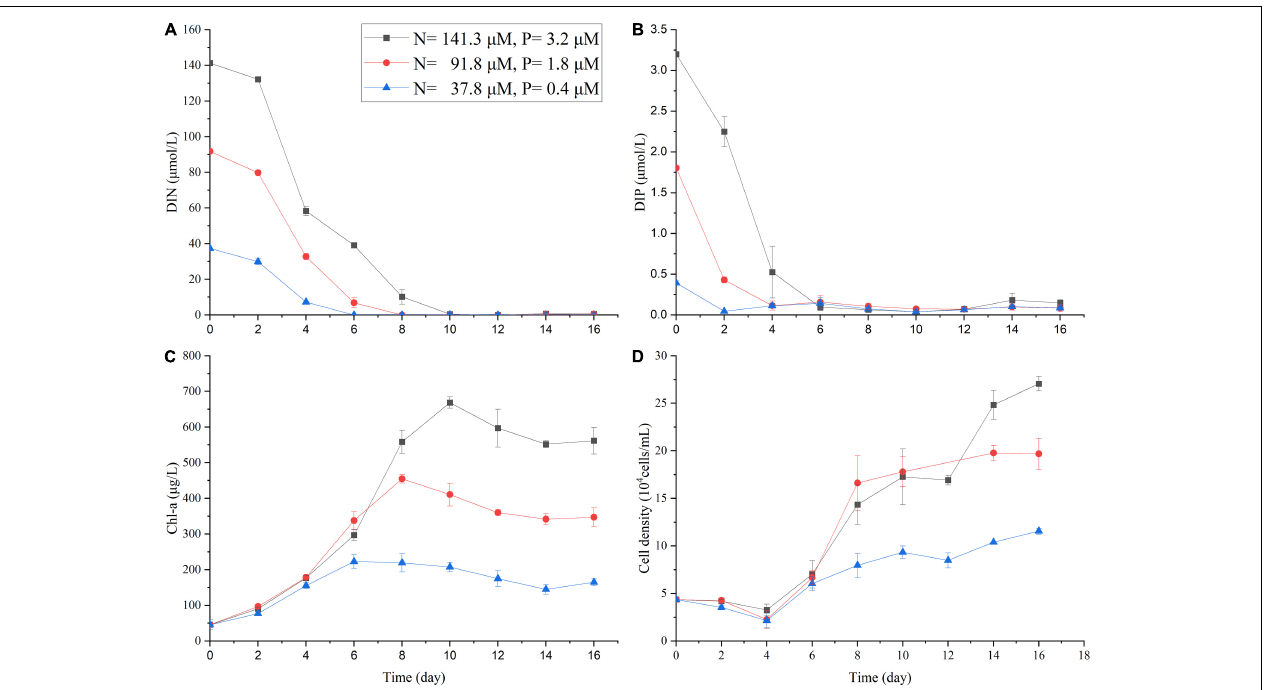
FIGURE 3 | The changes in DIN (A) , DIP (B) , Chl- a concentration (C) , and cell density of A. carterae (D) in the nutrient uptake experiment with three different nutrient concentrations. Other incubation conditions were the same as the single-factor nutrient experiment (SPM = 0 g/L, salinity = 30.5).